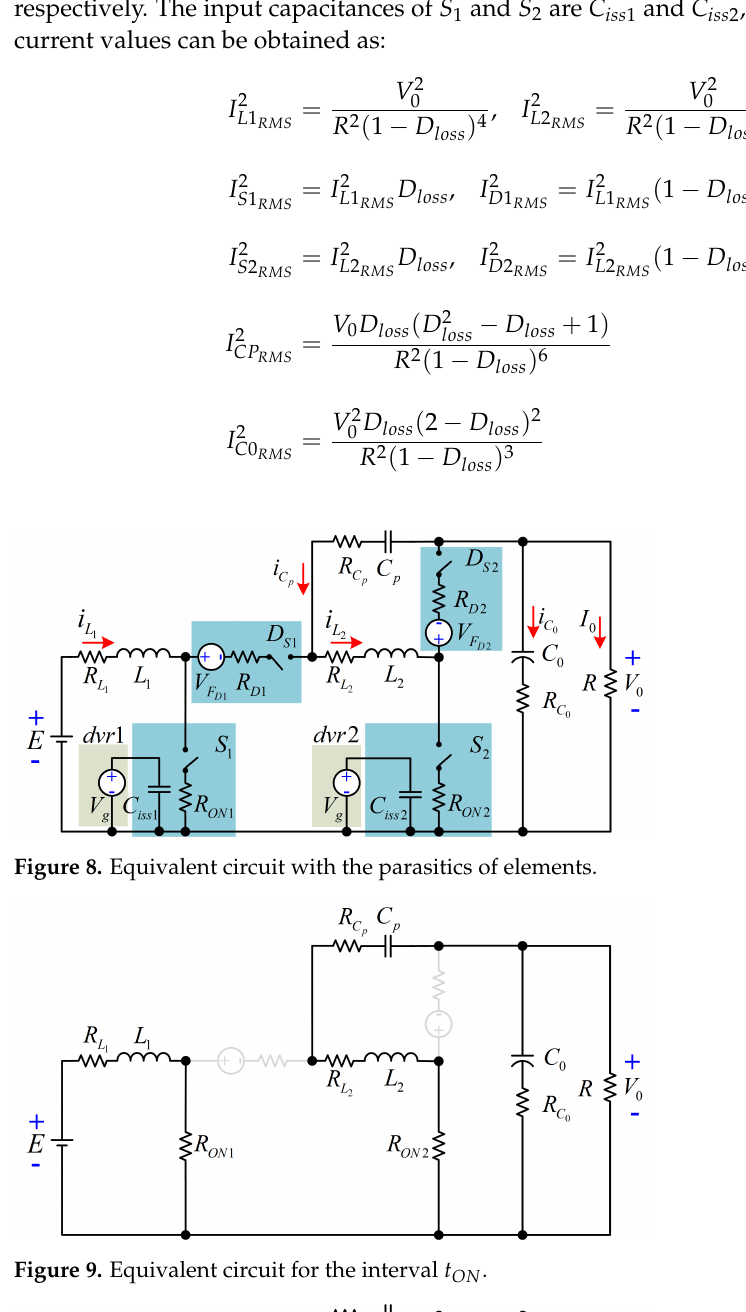
Figure 9. Equivalent circuit for the interval t ON .